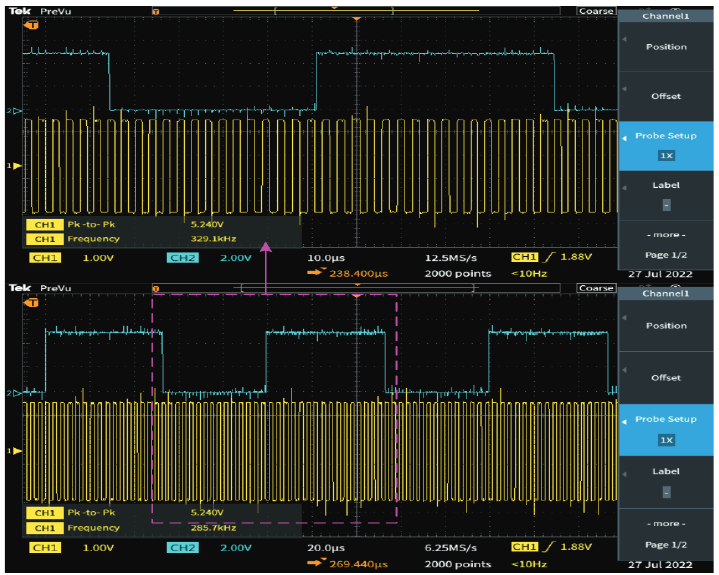
Figure 8. Voltage waveform of data